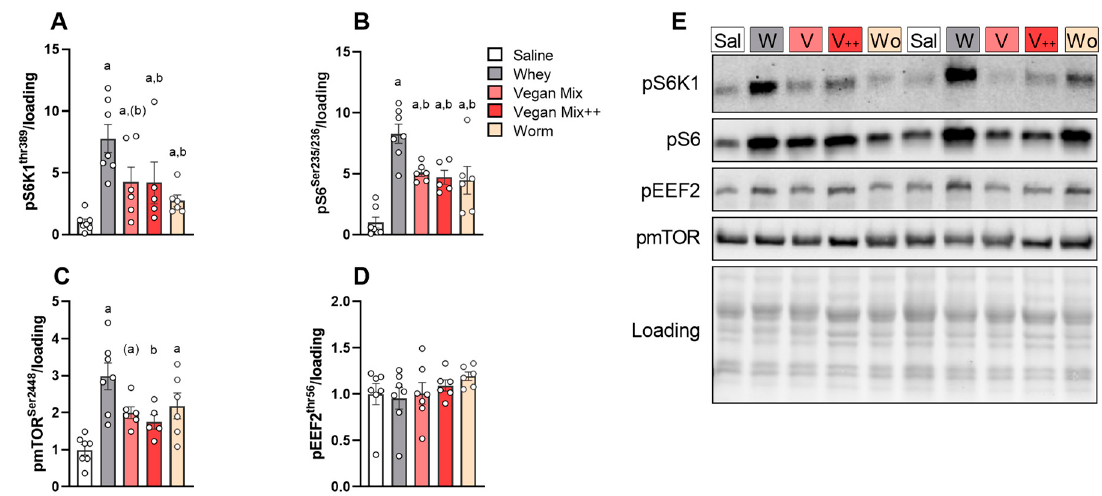
Figure 3. mTORC1 signalling 60 min in m. Tibialis Anterior after gavage of different AA mixtures. ( A ) pS6K1 Thr389 . ( B ) pRPS6 Ser235/236 . ( C ) pmTOR Ser2448 . ( D ) pEEF2 Thr56 . ( E ) Representative blots. Data is presented as mean ± SEM, n = 6–7. Sal (Saline), W (Whey), V (Vegan Mix), V++ (Vegan Mix++), Wo (Worm protein). a p < 0.05 vs. saline, b p < 0.05 vs. whey, (a) p < 0.10 vs. saline, (b) p < 0.10 vs. whey.